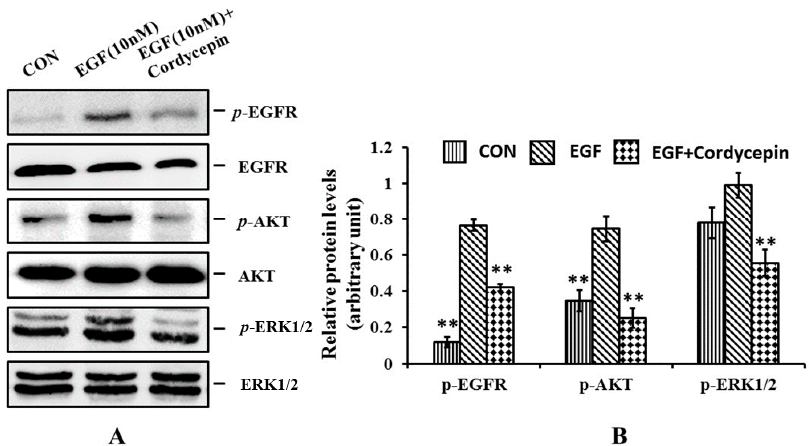
Figure 5. Effects of cordycepin on the apoptosis of H1975 cells and related proteins caspase-3 and Bcl-2 in vitro. ( A ) Western blot showed the phosphorylation level of caspase-3 and Bcl-2 following the cordycepin (10.22 µM) treatment for 24 h; ( B ) Histogram summarized the results of ( A ). Error bars represent means ± SEM of n = 3. ** p < 0.01 vs. control group.